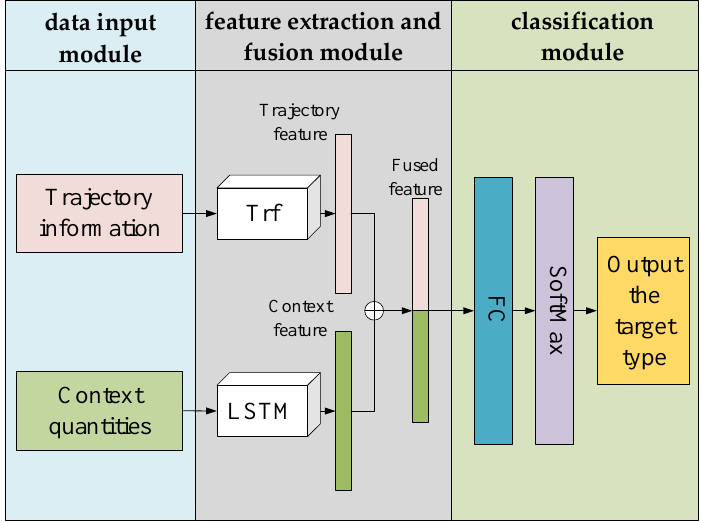
Figure 3. Network